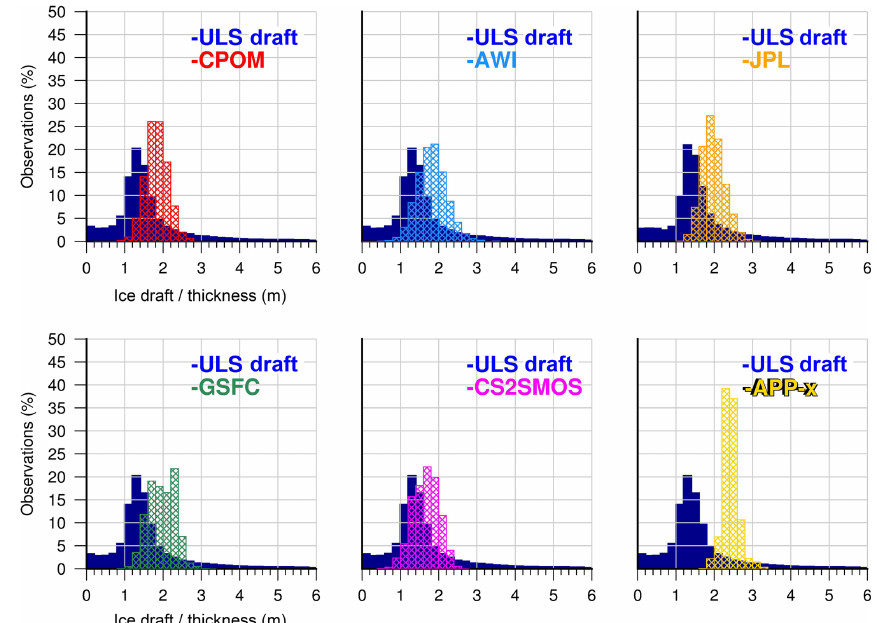
Figure 7. Spring (March–April) sea ice thickness distributions (cross-hatched) for each data product within 200km radius of BGEP mooring locations, averaged for the period 2011 to 2017 ∗ , overlaid on the corresponding BGEP upward looking sonar (ULS) ice draft distribution (dark blue, solid). ∗ The JPL data product averaging period is 2011 to 2015, and the APP-x data product average does not include thickness data for April 2017. Histogram bin width is